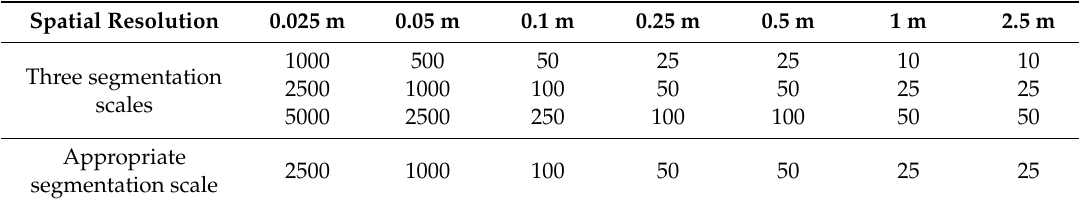
Appropriate segmentation Table 5. Appropriate scale parameters for secondary segmentation of multi-scale images.